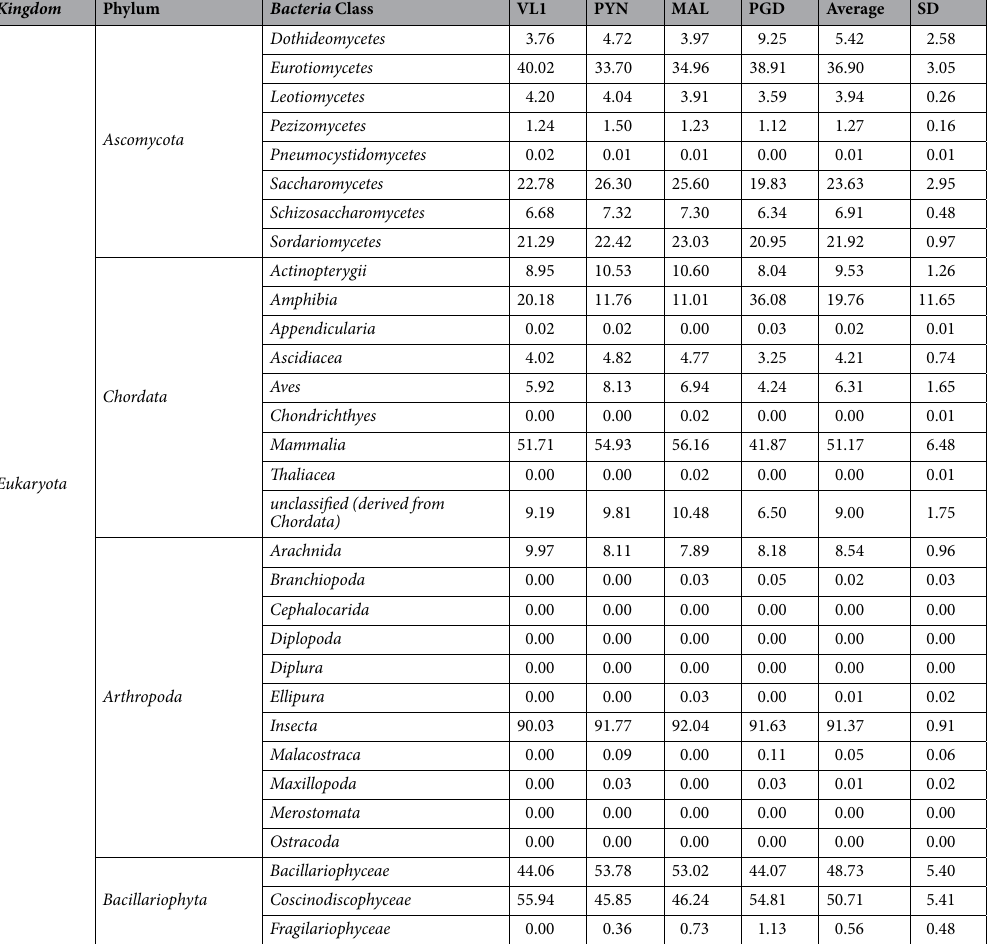
Table 2. Class taxonomic distribution across the samples isolated from a mangrove forest in Kerala,